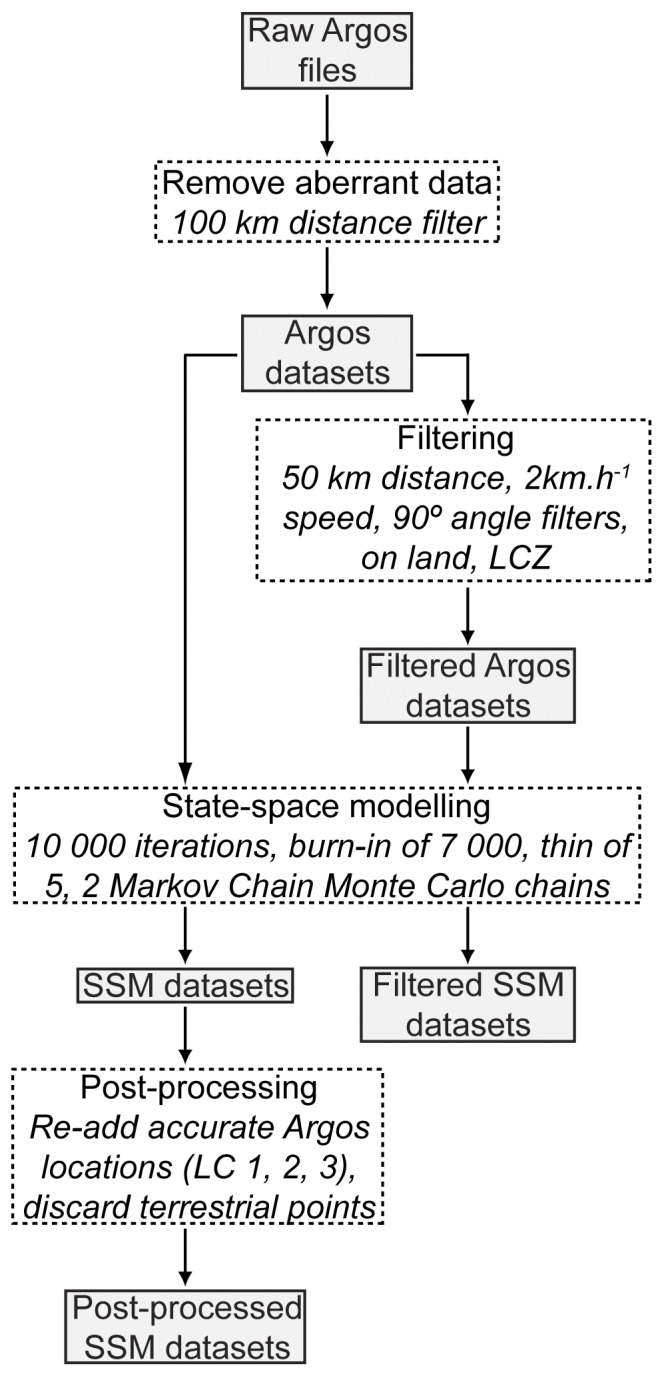
Flow diagram showing the different approaches used to obtain our five Argos-derived datasets.Data transformation procedures are indicated within dashed line boxes, datasets are indicated within solid line boxes.